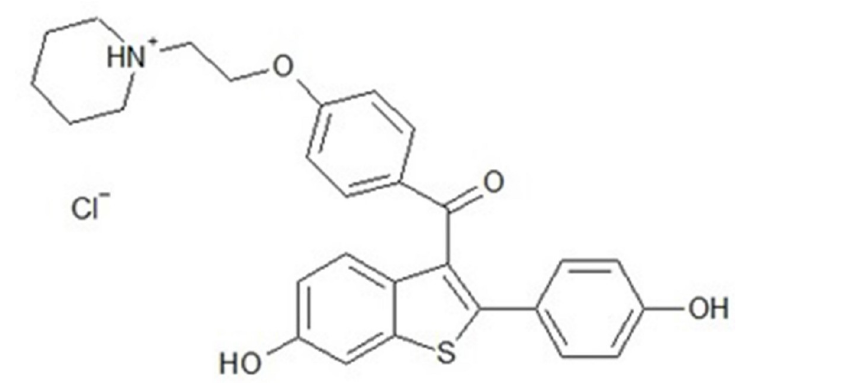
Fig 1. Chemical structure of